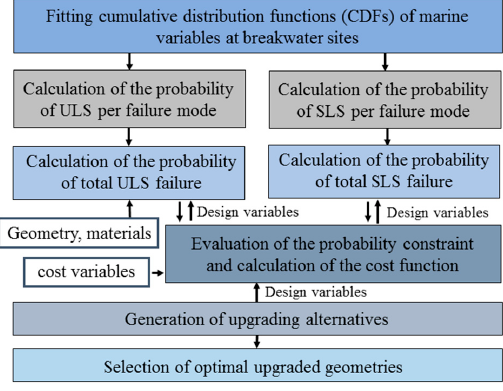
Figure 1. Schematic representation of reliability-based upgrading of a rubble mound structure.